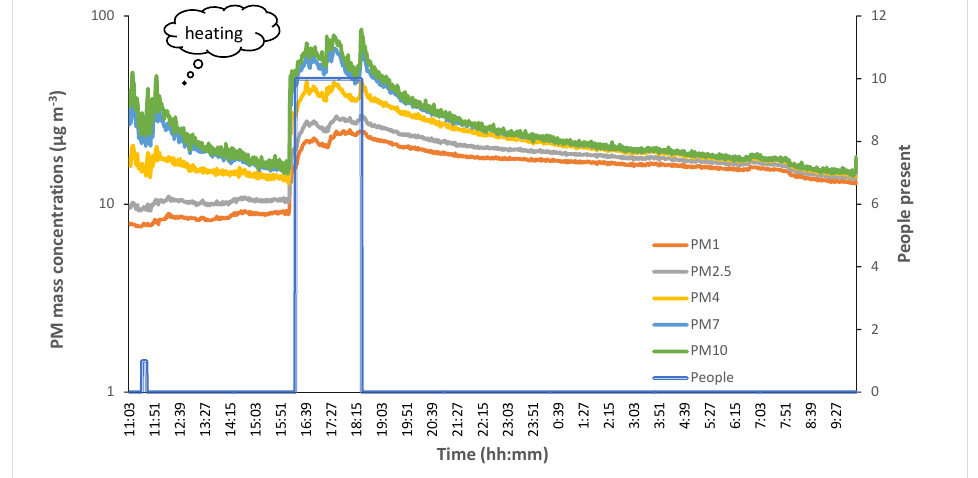
Figure 3. Campaign 2, Class: PM mass concentrations and number of people present.